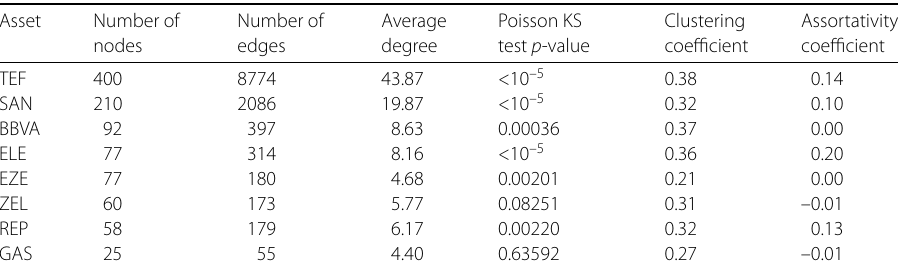
Table 1 Synchronization Network Features. Number of nodes, edges and average degree is shown in the first three columns for all networks. Fourth column refers to a Null Hypothesis testing based on Kolmogorov–Smirnov (KS) statistic for rejecting the hypothesis that underlying distribution for node out-degrees is a Poisson distribution, only p -value is shown. Fifth and sixth column show the Clustering Coefficient and Degree Assortativity of the undirected graph. The networks in this table have been built using “FDR” as described in methods section. Similar results can be found when using Bonferroni (see table S1) Asset Number of nodes